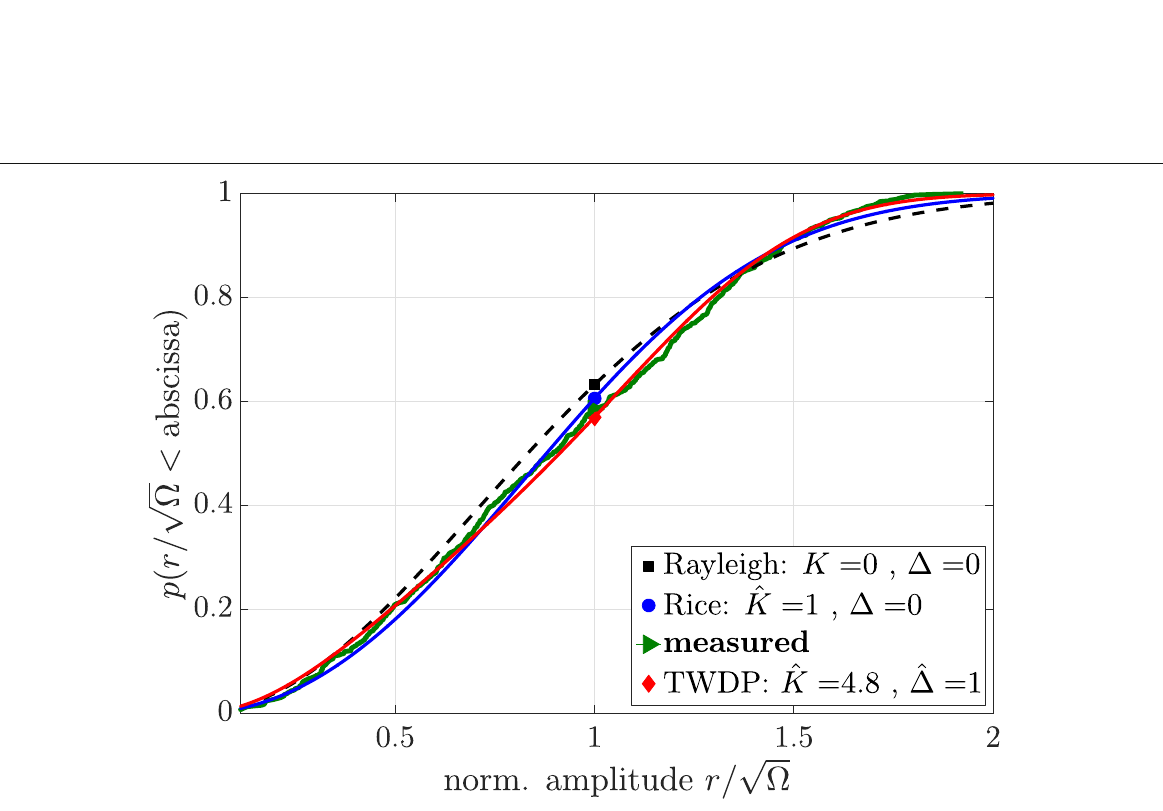
Fig. 16 CDF: Distribution fitting for spatial measurement data, time gated by the channel tap at 2.5m, ϕ = 160 ◦ , and θ = 110 ◦ . Note that, similar